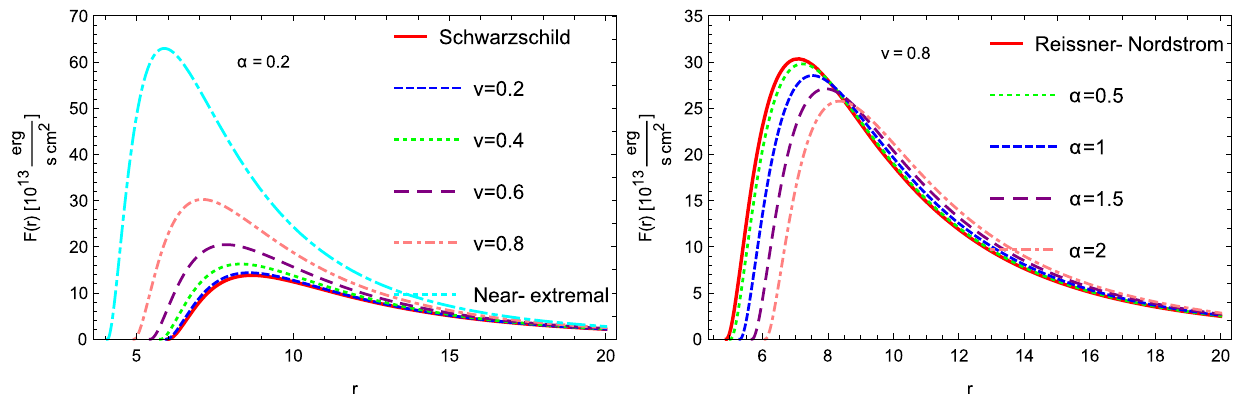
Fig. 2 The energy flux F ( r ) of a disk around a static charged dilaton black hole with the mass accretion rate ˙ M = 2 × 10 − 6 M (cid:10) year − 1 , for different values of v , left panel and different values of α , right panel. ThesolidcurvescorrespondtotheSchwarzschild( v = 0)andReissner-